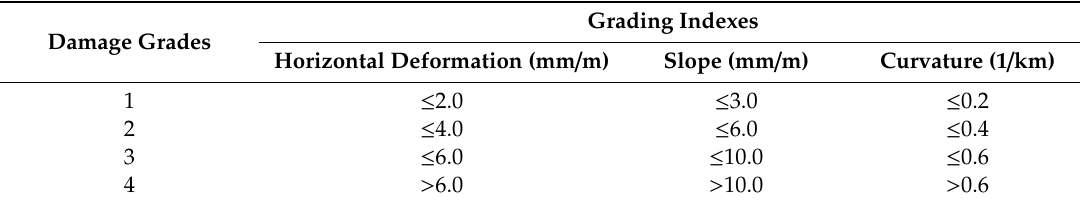
Table 6. Grading criteria of timberland damage induced by mining subsidence [50]. Damage